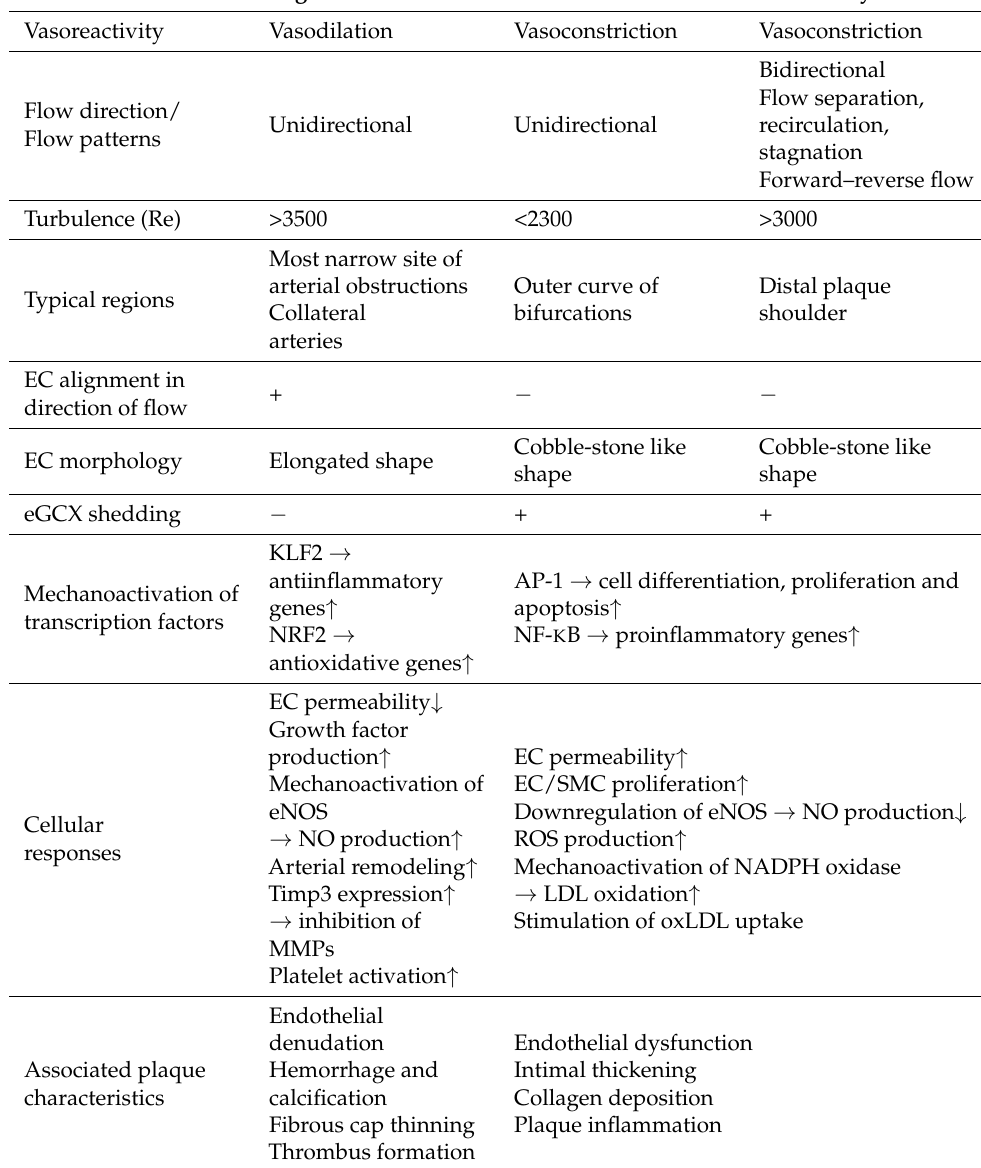
Table 1. Characterization of shear stress patterns in the human